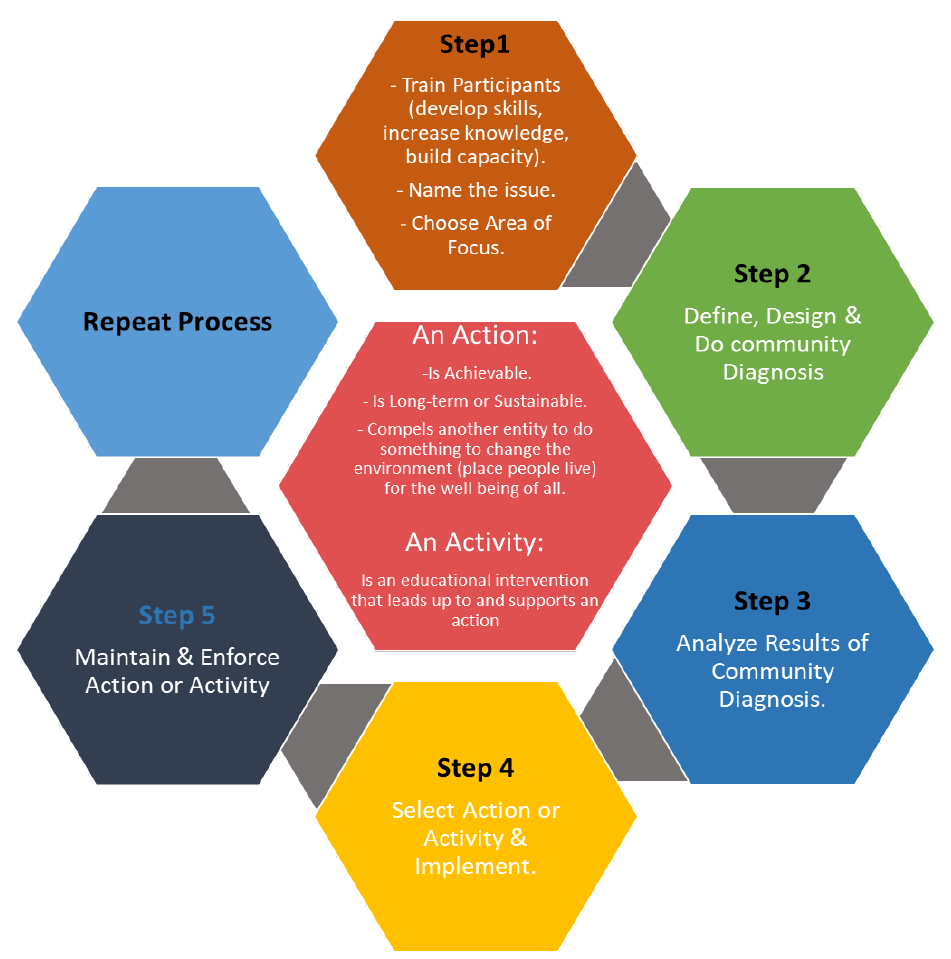
Figure 2. Community action model process (Adapted from “Community Action Model: Creating Change by Building Community Capacity,” by San Francisco Tobacco -Free, 2016, https://sanfran- ciscotobaccofreeproject.org/actions/community-action-model/ (accessed on 1 June 2022)). //sanfranciscotobaccofreeproject.org/actions/community-action-model/ (accessed on 1 June